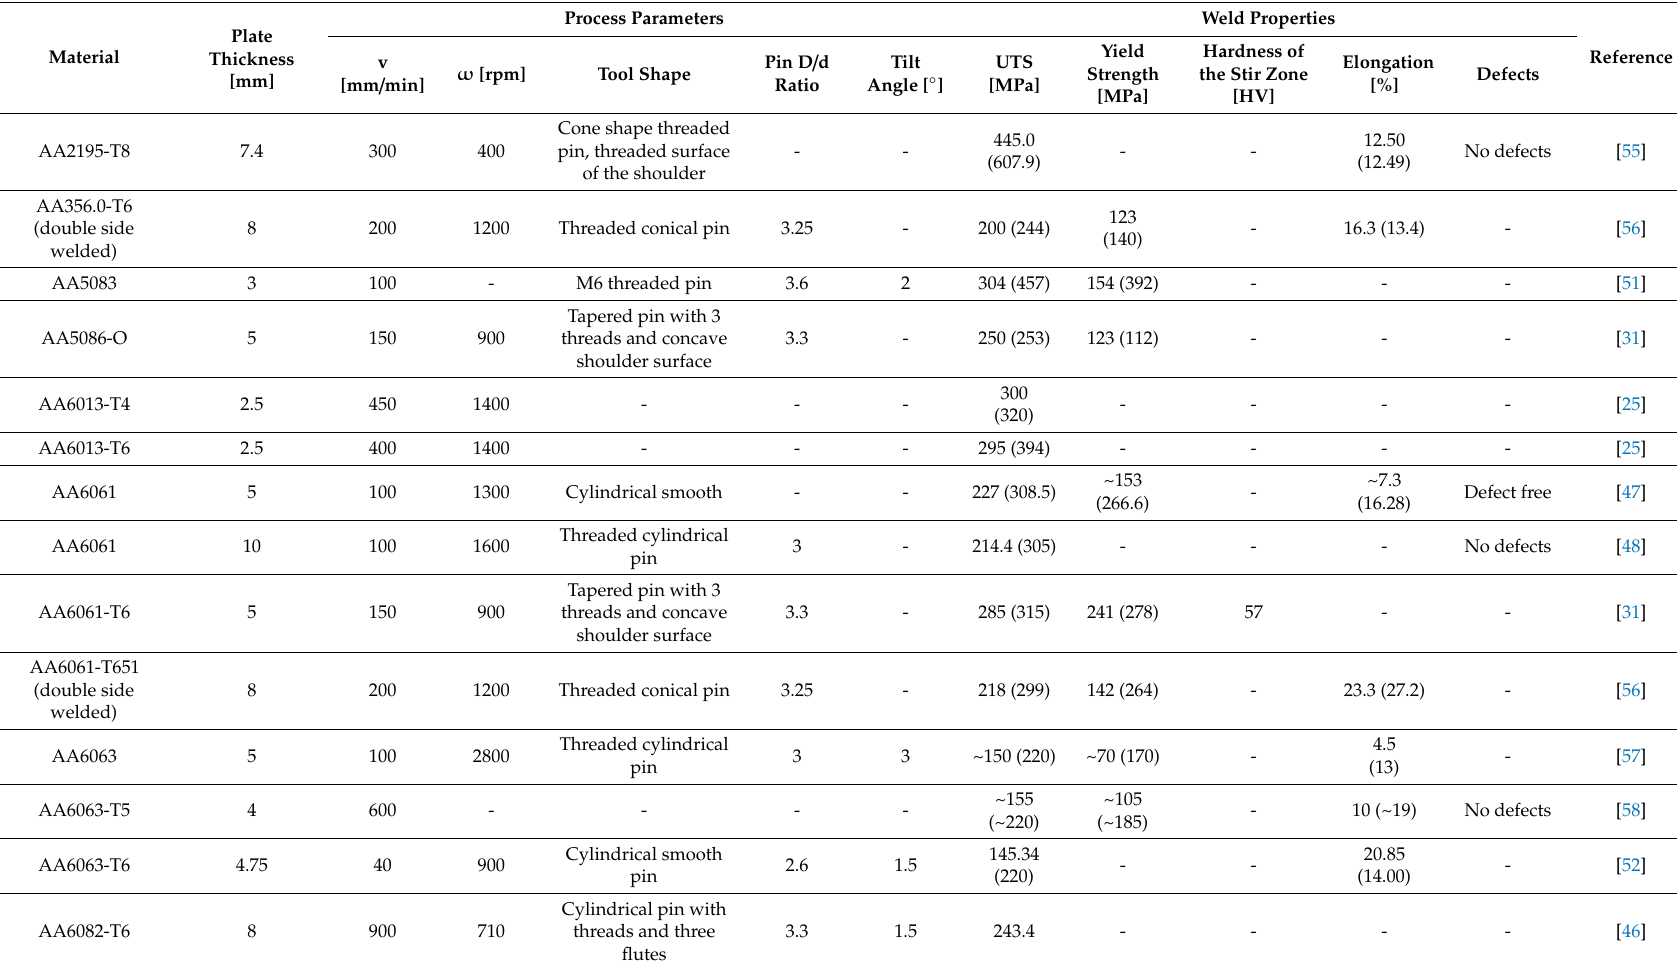
Table 1. FSW of aluminum and its alloys—process parameters and mechanical properties of the